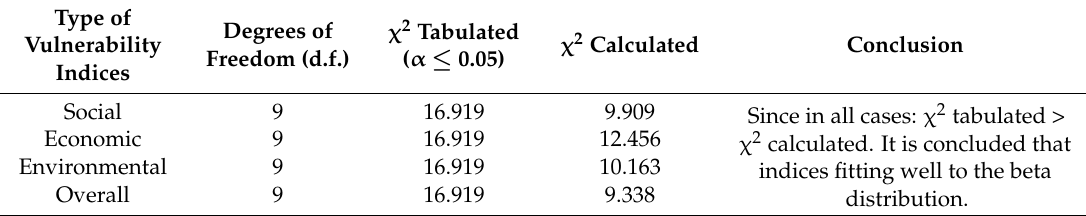
Table 7. Results of the Pearson’s chi-square goodness-of-fit test ( χ 2 ) for all types of vulnerability indices.